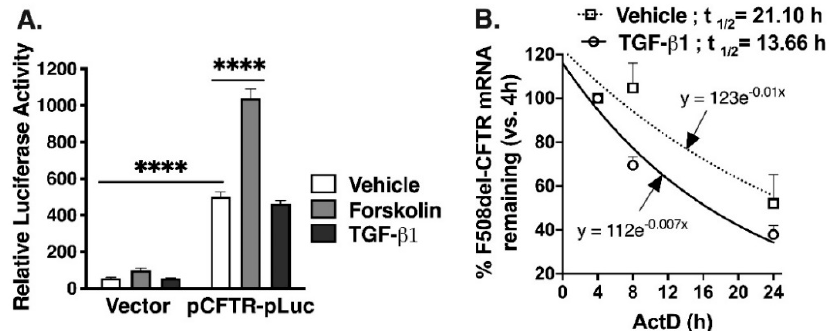
Figure 2. TGF- β 1 did not a ff ect CFTR promoter activity but reduced the stability of CFTR mRNA. ( A ). Summary of the CFTR gene promoter reporter assays showing that luciferase activity was increased by expression of the vector containing 1 kb promoter pCFTR-pLuc, compared to vector control. Forskolin increased the luciferase activity of pCFTR-pLuc and TGF- β 1 had no e ff ect. Human embryonic kidney (HEK) cells were transfected with pCFTR-pLuc or vector control and 24 h later cells were treated with forskolin (10 µ M), TGF- β 1 (15 ng / mL), or vehicle control for 6 h. ( B ). The CFTR mRNA half-life measurements showing that TGF- β 1 decreased CFTR mRNA stability in F508del HBE cells. The transcriptional inhibitor ActD (5 µ g / mL) and either TGF- β 1 or vehicle control were added to F508del HBE cells for 4, 8 or 24 h. Total RNA was isolated and the CFTR mRNA level at each time point was calculated by real-time quantitative reverse transcriptase PCR (qRT-PCR), using the relative quantitation method, with 18S as a reference gene. The amount of CFTR mRNA at 4 h was set to 100% ( t = 0) and mRNA half-lives were calculated from the exponential decay model, based on trend line equation C / C 0 = e − kdt (where C and C 0 are mRNA amounts at the time t and t 0 , respectively, and k d is the mRNA decay constant). The resulting curve equations were y (vehicle) = 123 − 0.01x and y (TGF- β 1) = 112 − 0.007x . The calculated half-life of CFTR mRNA was 21.1 h and 13.7 h for the vehicle and TGF- β 1-treated cells, respectively. N = 9–12 / group from 3–4 di ff erent HEK cell cultures ( A ) and N = 3 in triplicates in F508del HBE cells from three di ff erent donors ( B ). Error bars, S.E.M. **** p < 0.0001.